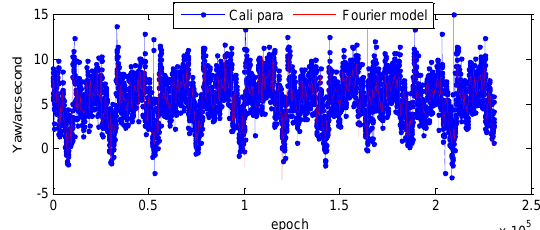
Figure 7. Chart of conversion parameters variation in yaw direction between internal and earth observation camera datum